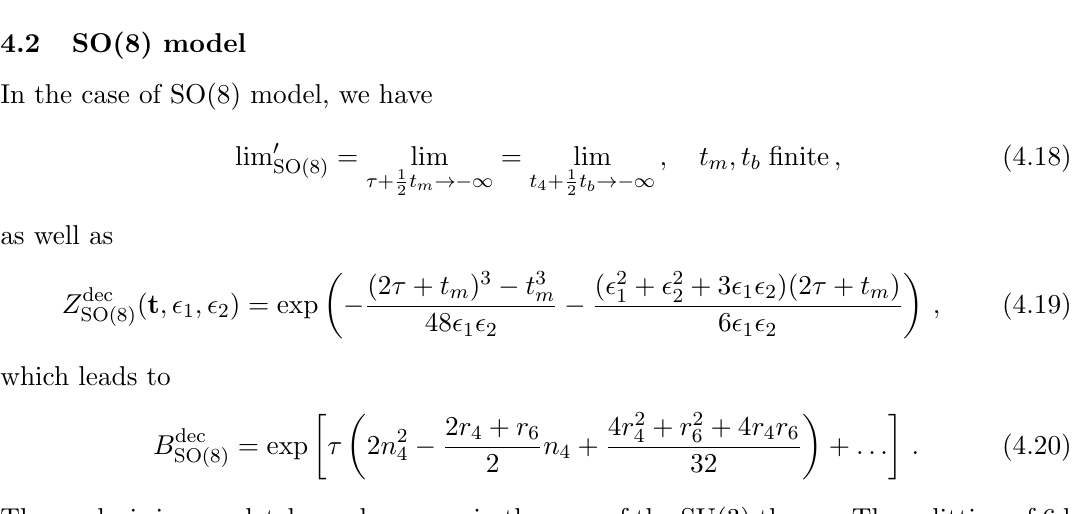
Table 3. Reduction of 6d r (cid:12)elds to 5d r (cid:12)elds and corresponding (cid:3) and vanishing r (cid:12)elds are colored in blue and green